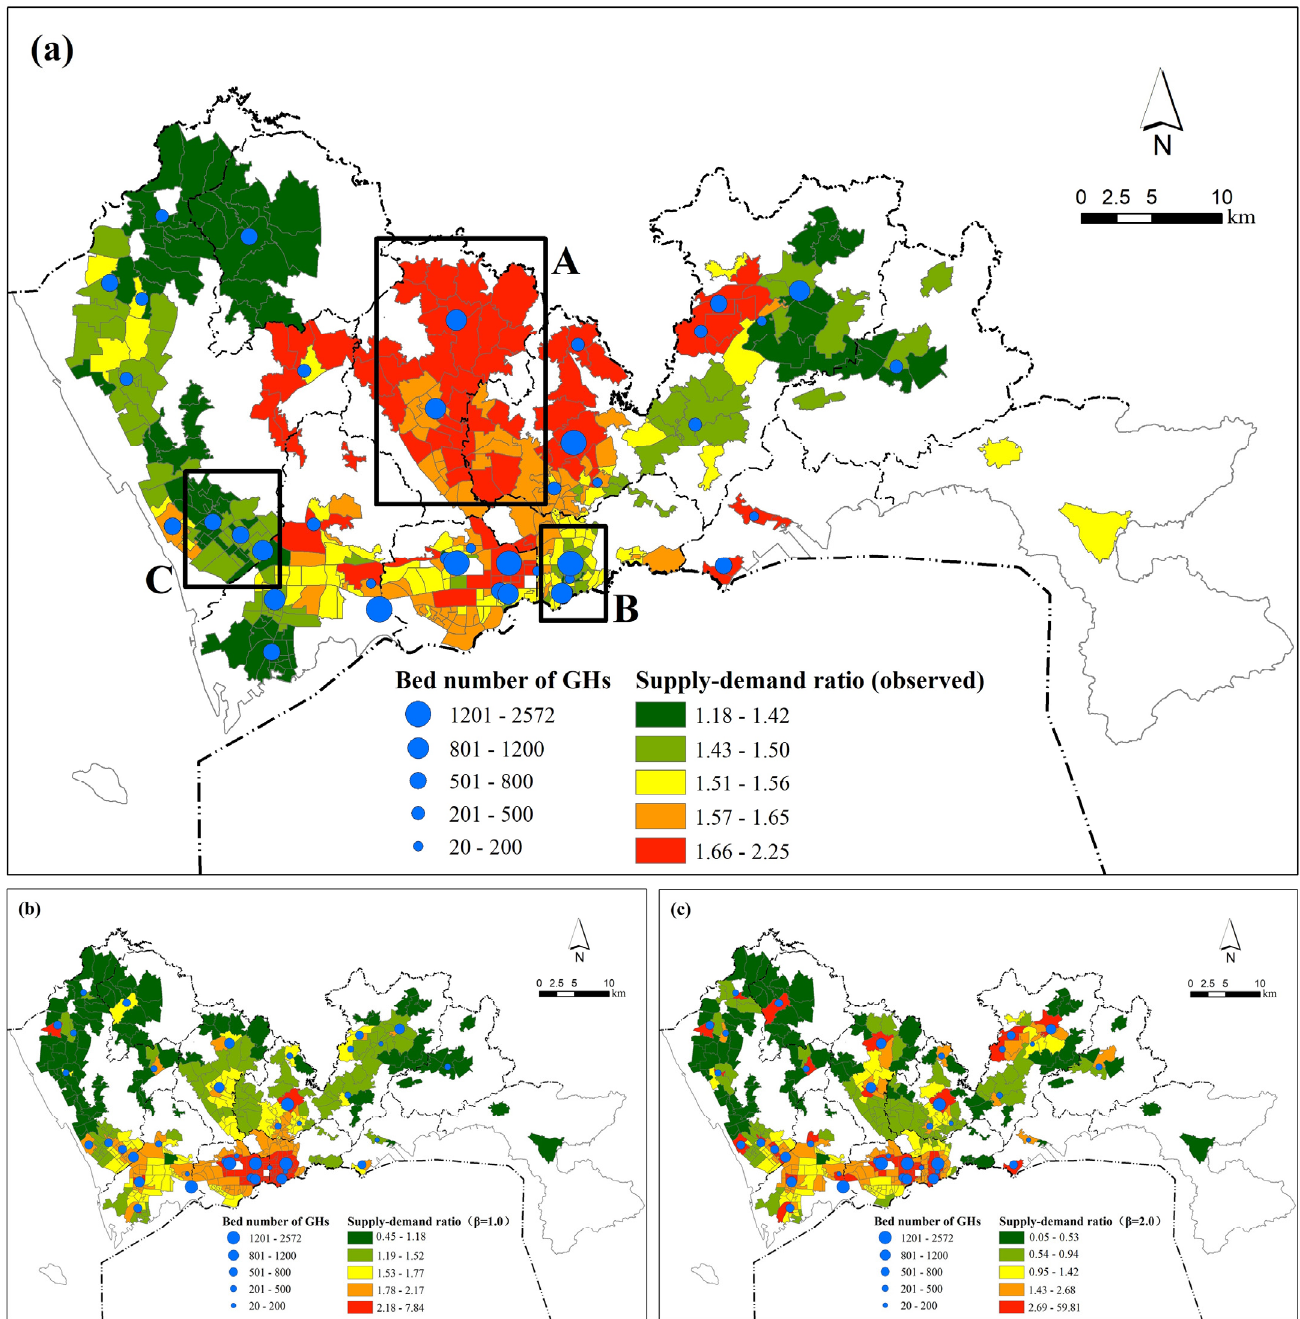
Figure 4. Comparison of supply–demand ratio in Shenzhen: ( a ) observed; ( b , c ) show the classical accessibility method when the decay coefficient ( β ) is taken as 1.0 and 2.0, respectively. Data source: bed number of GHs, Health Commission of Shenzhen; supply–demand ratio, calculated by the methods in 3.3.